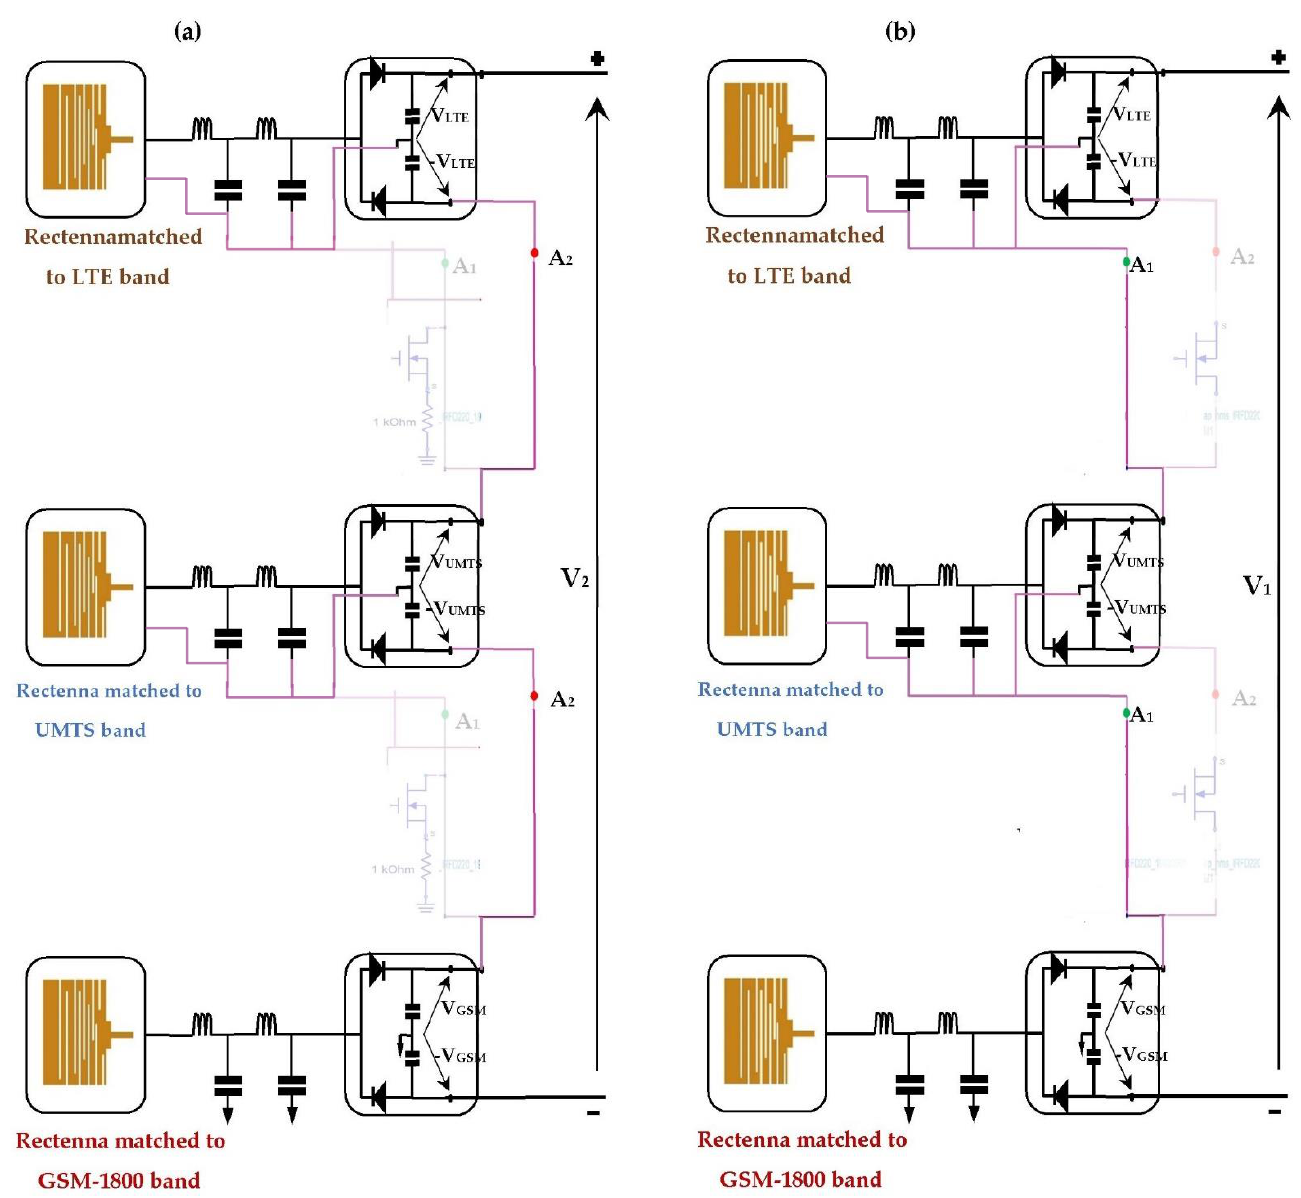
Figure 27. Switching between both previous architectures according to the input power levels. ( a ) for high input power levels, ( b ) for low input power